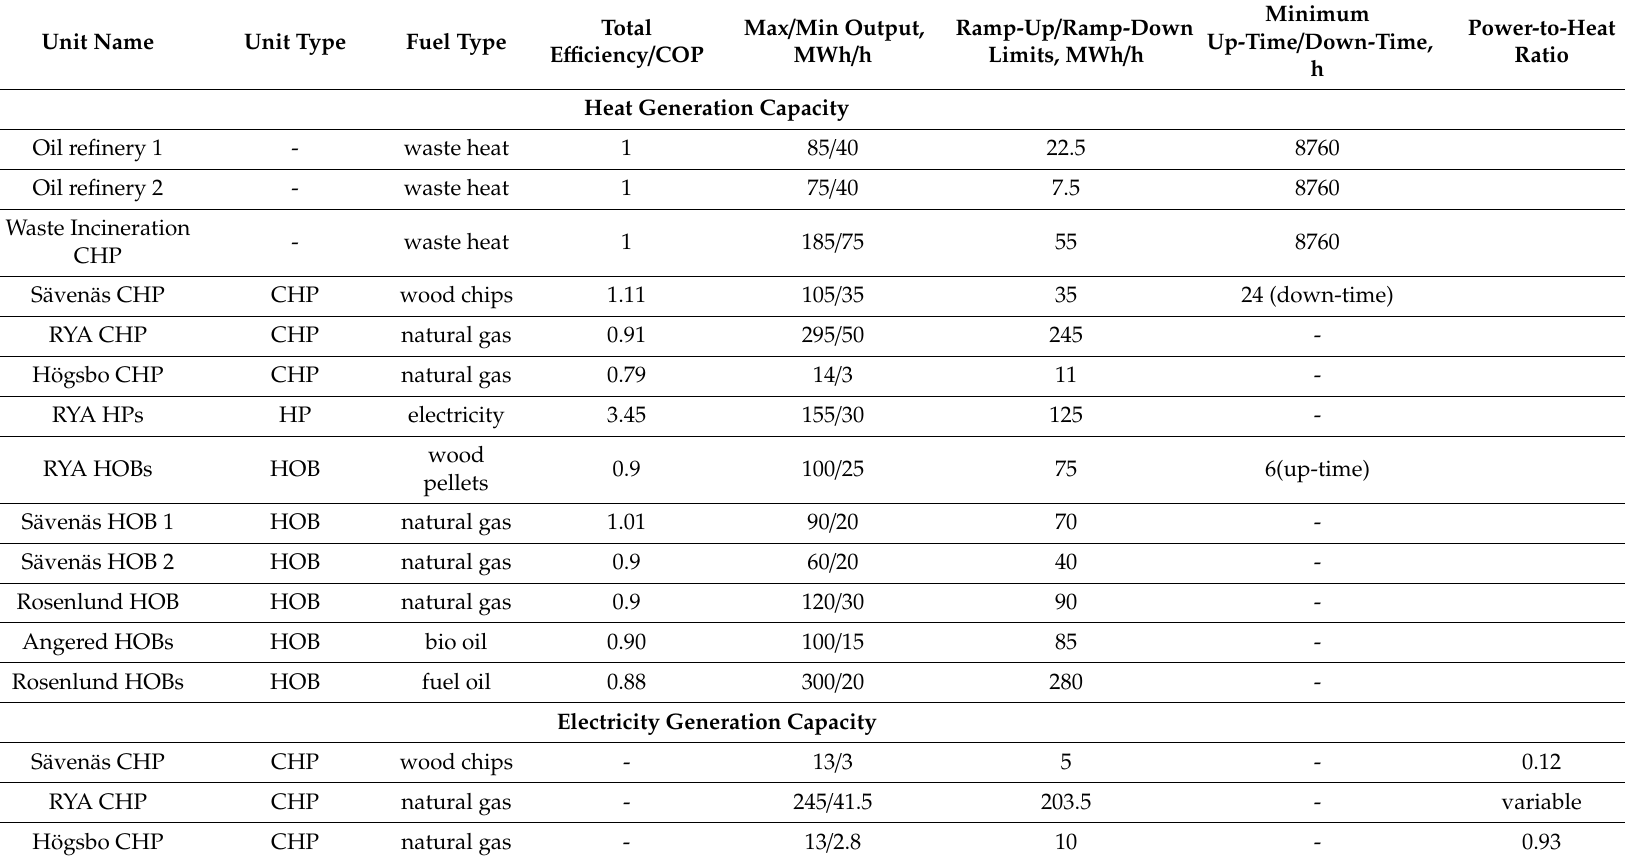
Table A1. Parameters of the heat-only boilers (HOBs) and combined heat and power (CHP) generation units available in the district heating system of Gothenburg. The e ffi ciencies of the Sävenäs CHP and the Sävenäs HOB1 units have values higher than “1” because the calculations are performed based on the lower heating value of the fuel (a flue gas condensation technology is used in these